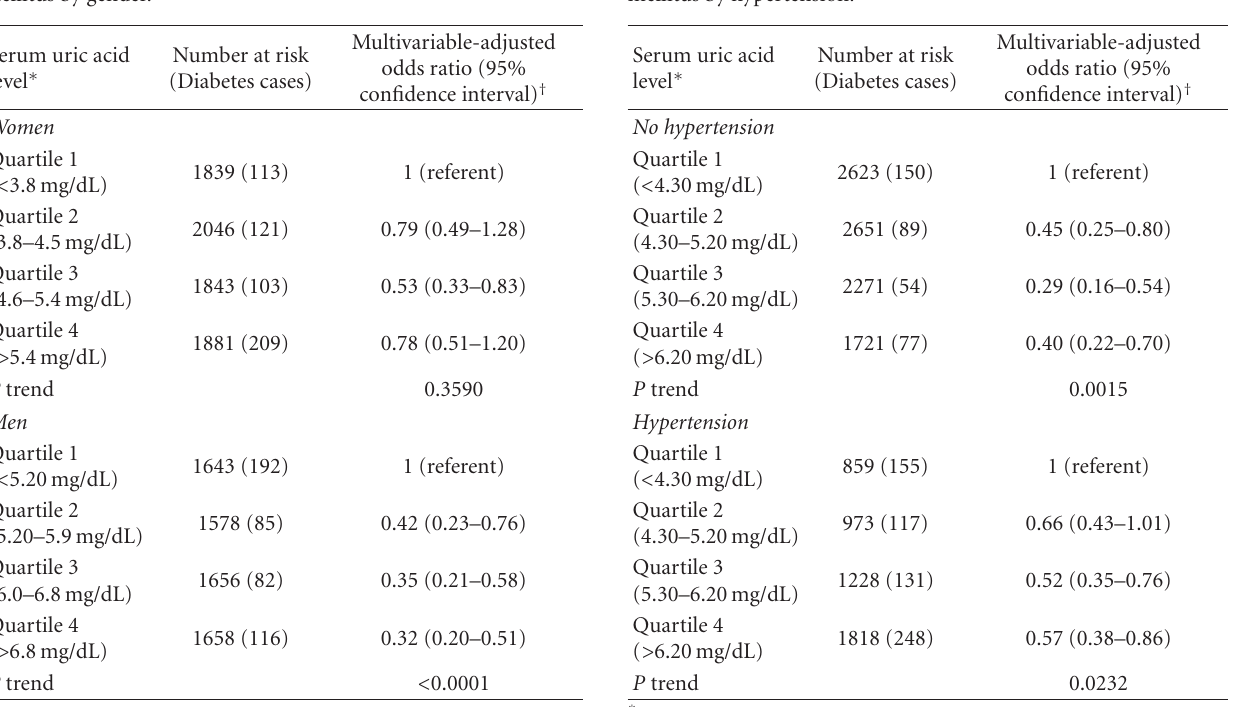
Table 3: Association between serum uric acid level and diabetes mellitus by gender.